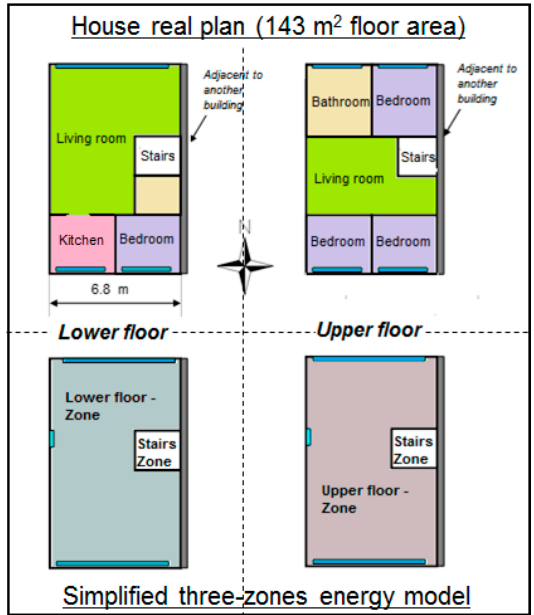
Figure 2. The investigated two-storey dwelling.